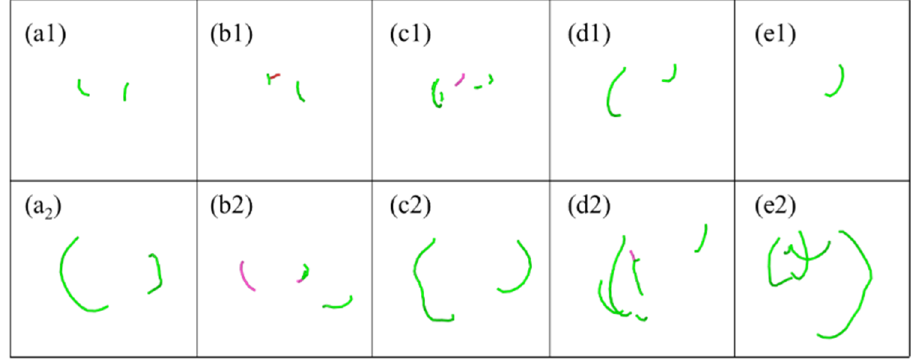
Figure 6. Dislocation line evolutions of five different Zr content in Figure 5 a – e under different depths. ( a1 – a2 ) 0 wt.%, ( b1 – b2 ) 2 wt.% ( c1 – c2 ) 3 wt.%, ( d1 – d2 ) 4 wt.% and ( e1 – e2 ) 5 wt.%, with subscripts 1, 2 standing for 1.5 nm and 2.0 nm, respectively.